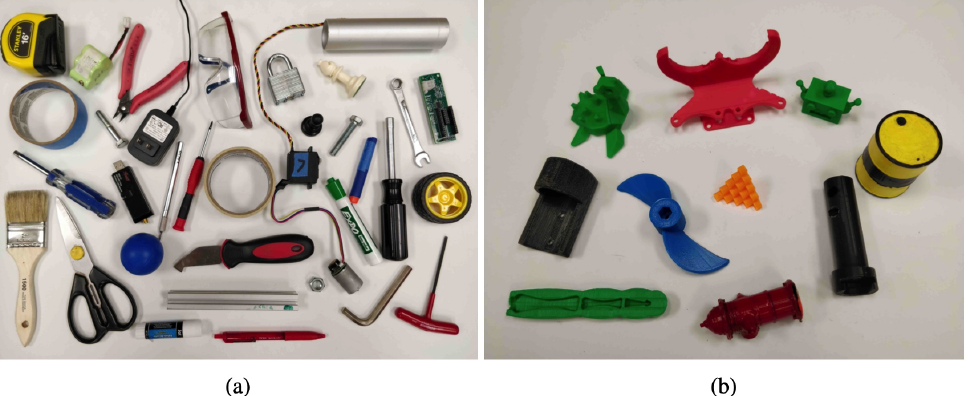
Figure 13. Objects used for robotic grasping experiments. ( a ) Household test objects. ( b ) Adversarial test